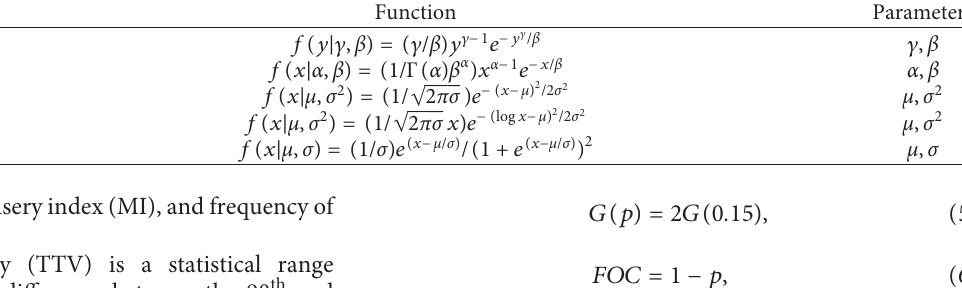
Table 2: Description of five distributions. Function